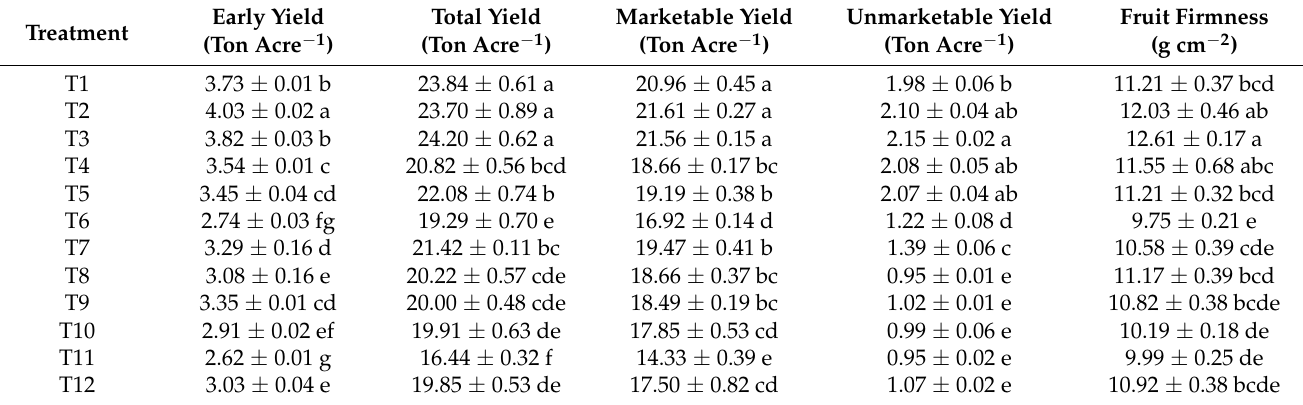
Table 5. Effect of potassium treatments on yield traits of strawberry plants in the combined seasons